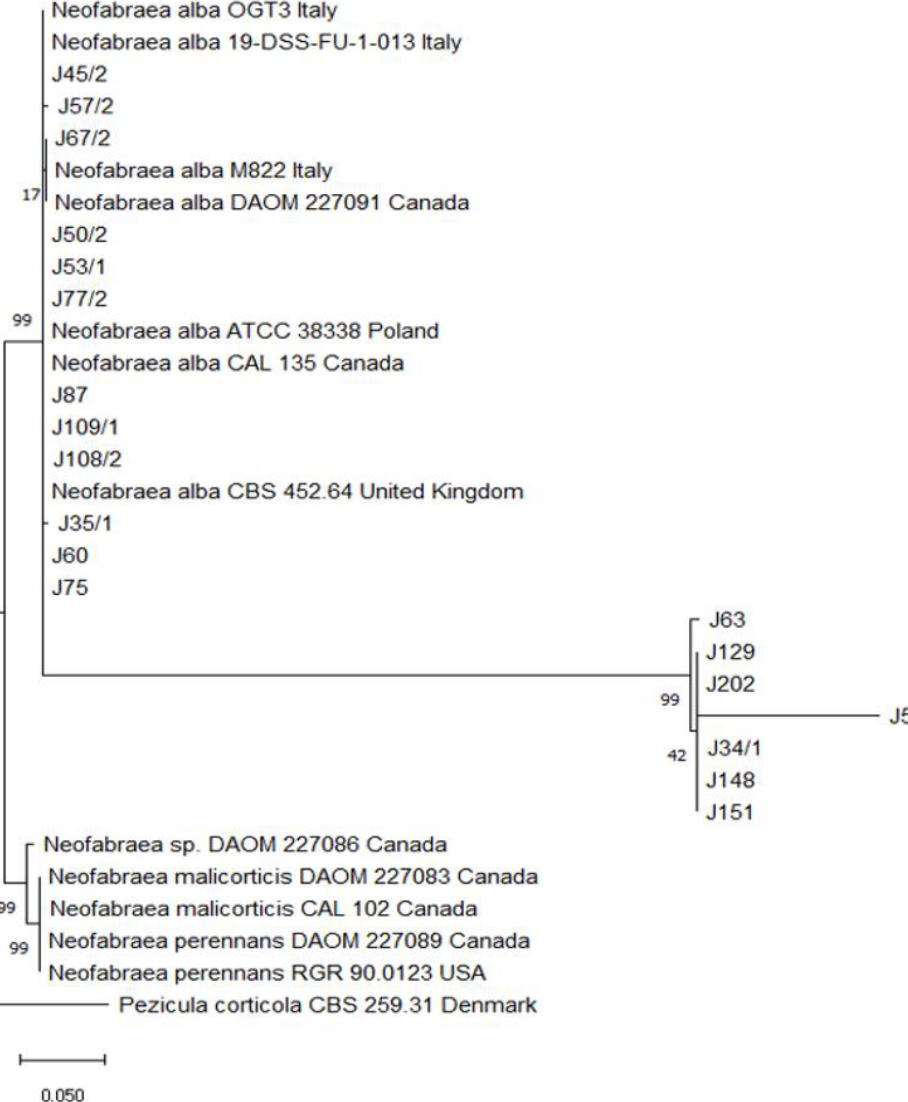
Figure 8. Maximum-likelihood concatenated tree constructed using MEGA 7 software [21], based on the internal transcribed spacer (ITS) and 16S mitochondrial ribosomal RNA gene (mtSSU) sequences of Neofabraea spp. Pezicula corticola was used as an outgroup. The numbers at the branches represent bootstrap values obtained after 1000 replications.